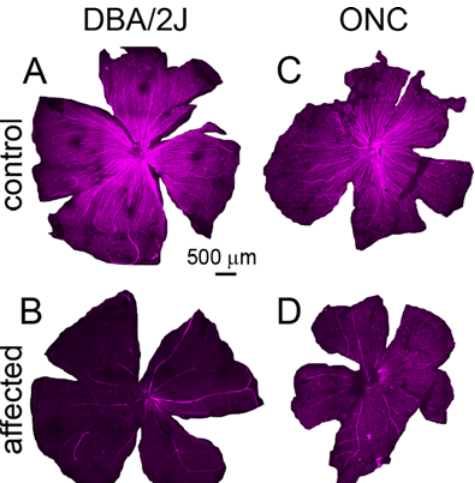
Fig 3. Retina whole-mounts stained for the axonal marker SMI32 (neurofilament). A, D2.Gpnmb+ mice with no axon loss. B, retina from a 11 month old DBA/2J mouse with severe loss of ganglion cells and axons. C. Control retina from a C57bl/6 mouse. D. Retina from a C57bl/6 mouse 7 days after optic nerve